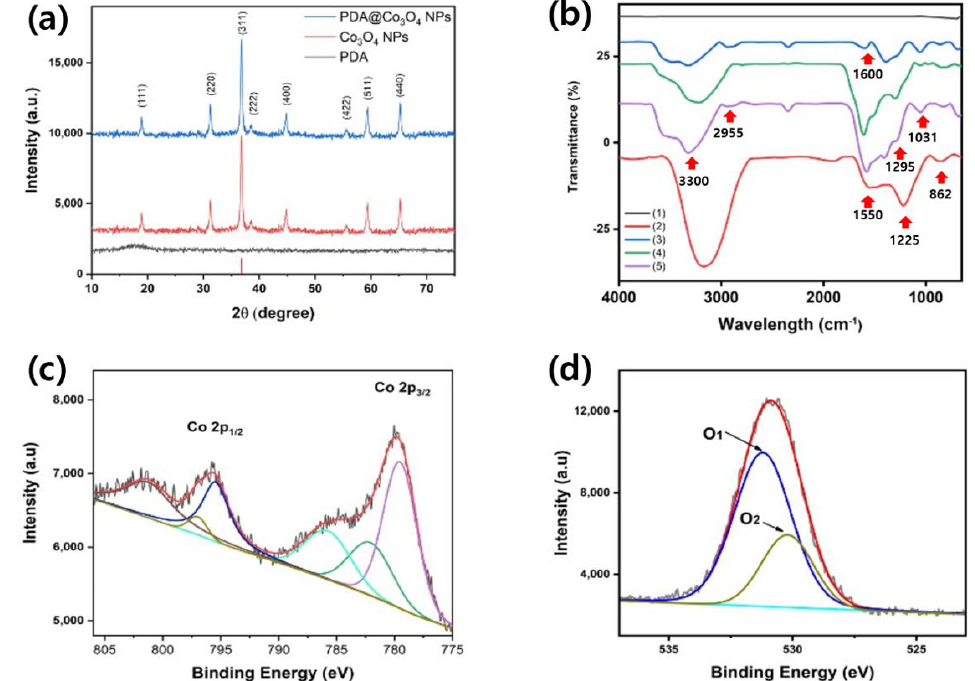
Figure 3. ( a ) XRD spectra, ( b ) FT-IR spectra of bare Co 3 O 4 NPs, PDA, 0.5 − PDA@Co 3 O 4 NPs, 1 − PDA@Co 3 O 4 NPs, and 2 − PDA@Co 3 O 4 NPs (denoted as 1, 2, 3, 4, and 5, respectively), and